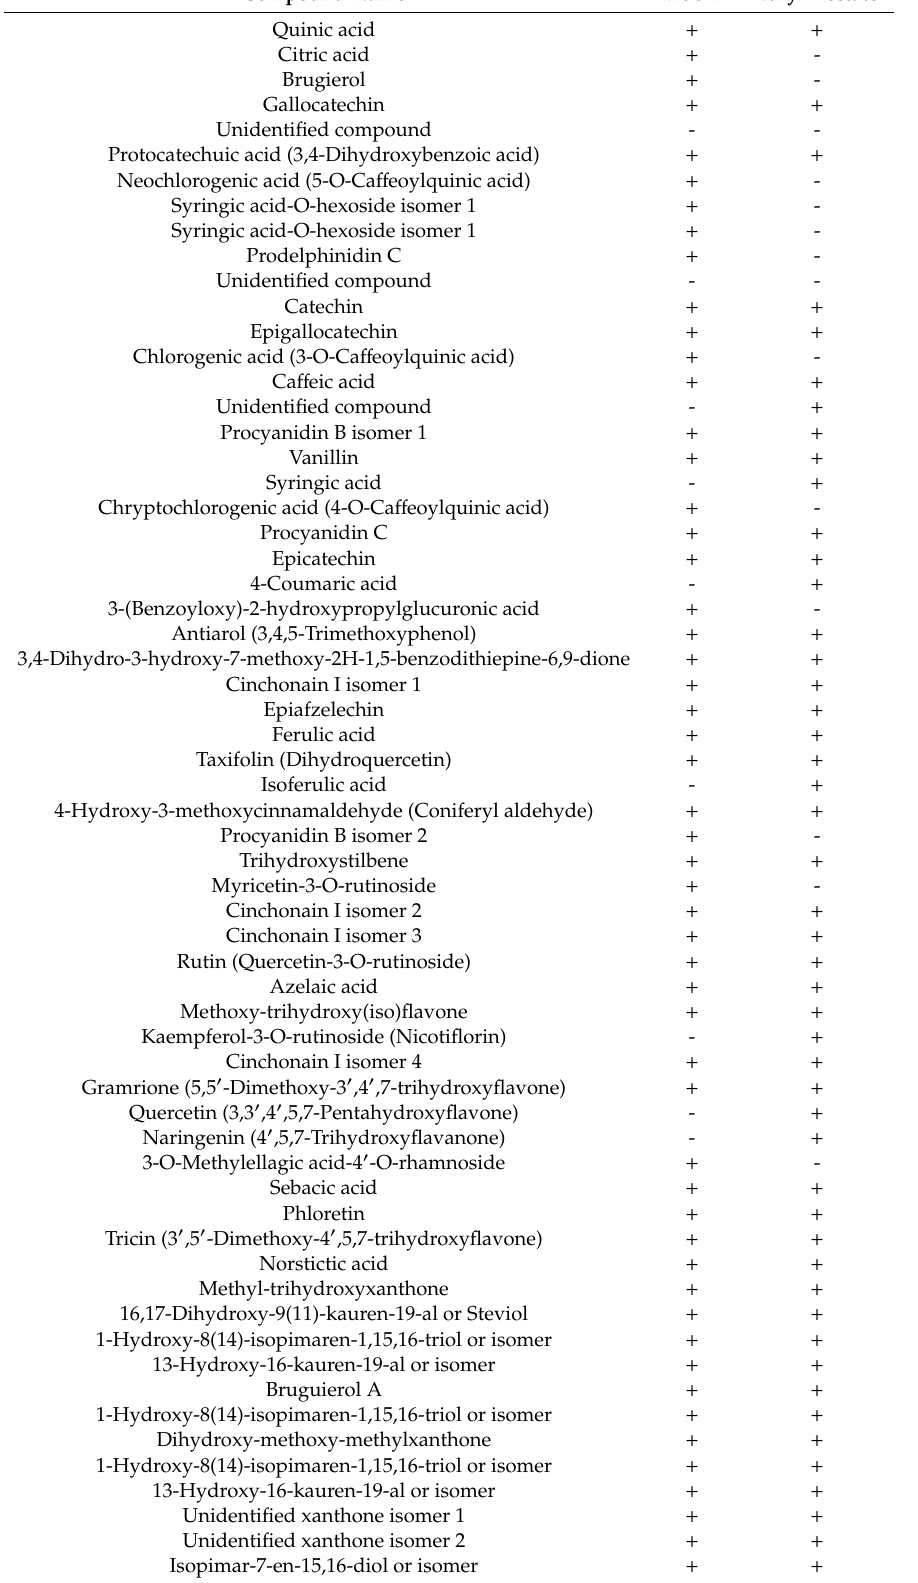
Table 3. Chemical composition of root